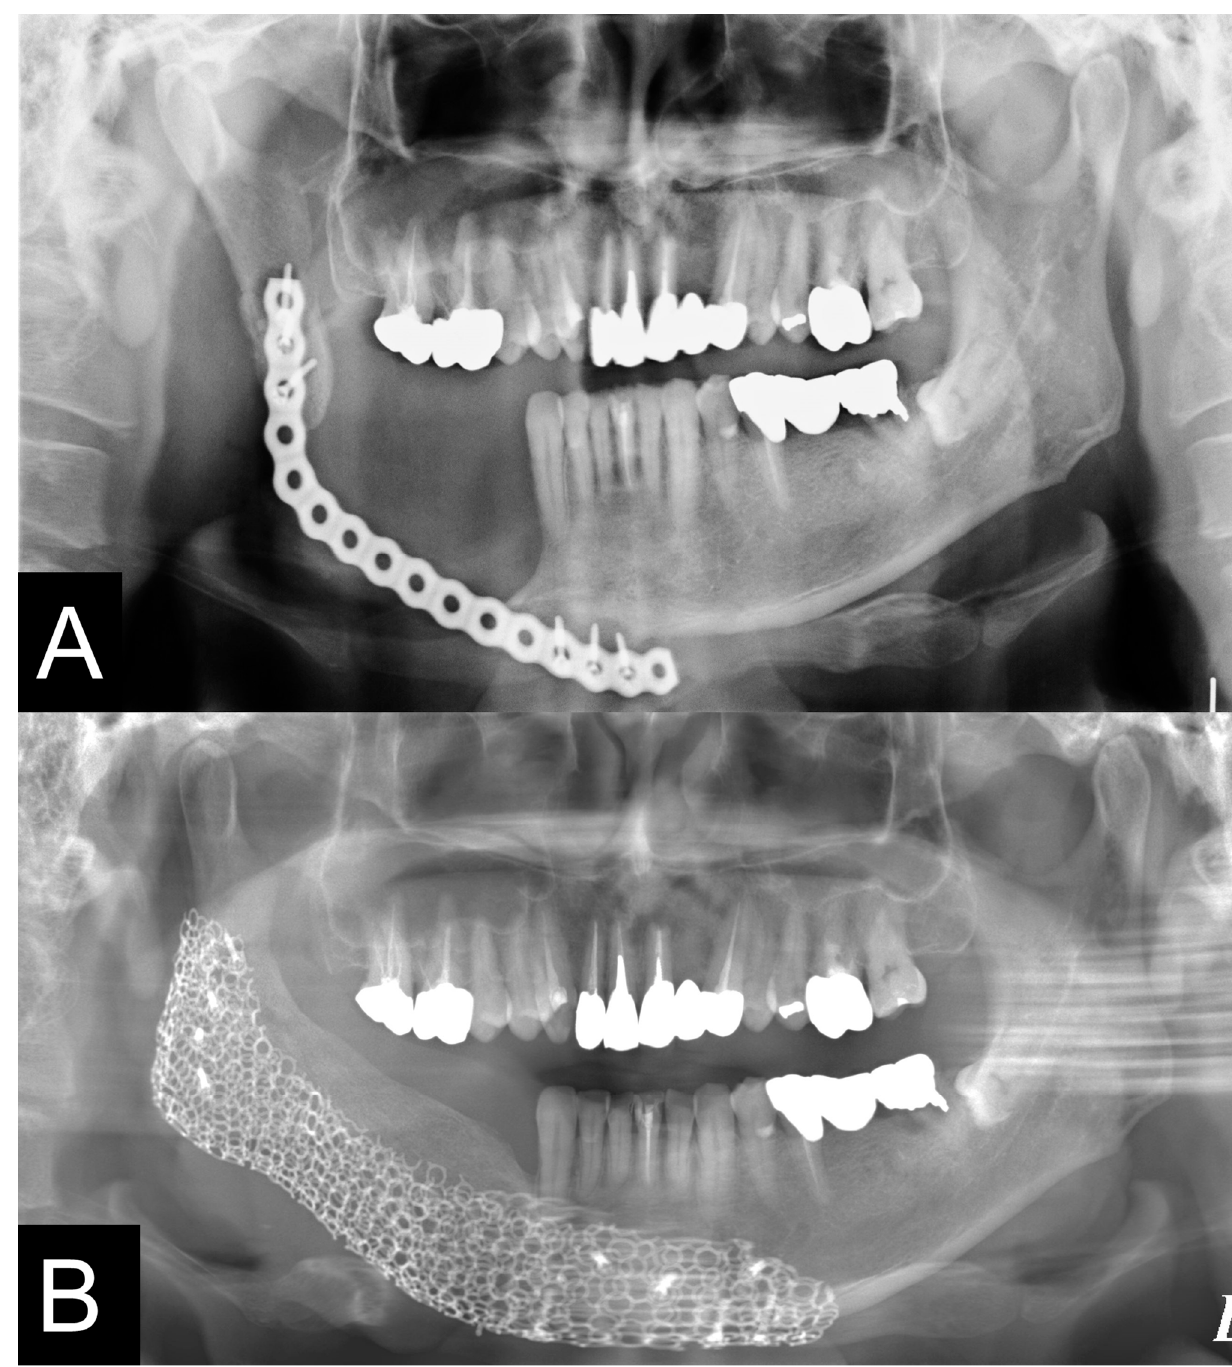
Figure 10. Pre- and postoperative panoramic radiographs showed accurate jaw reconstruction. ( A , B ). The fractured plate was removed, the pre-bended custom-made TiMesh was fixed with a positioning device, and a PCBM was transplanted. After the operation, the mandibular deviation was corrected and the position of the condyle was improved.